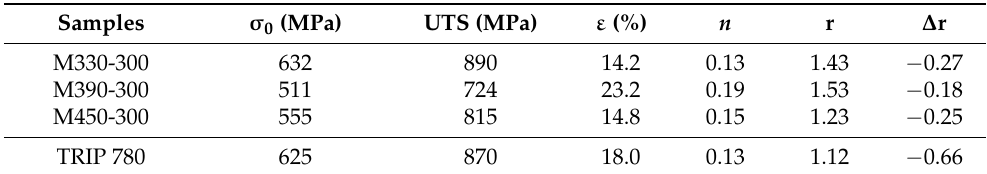
Table 5. Mechanical properties of the studied steels.